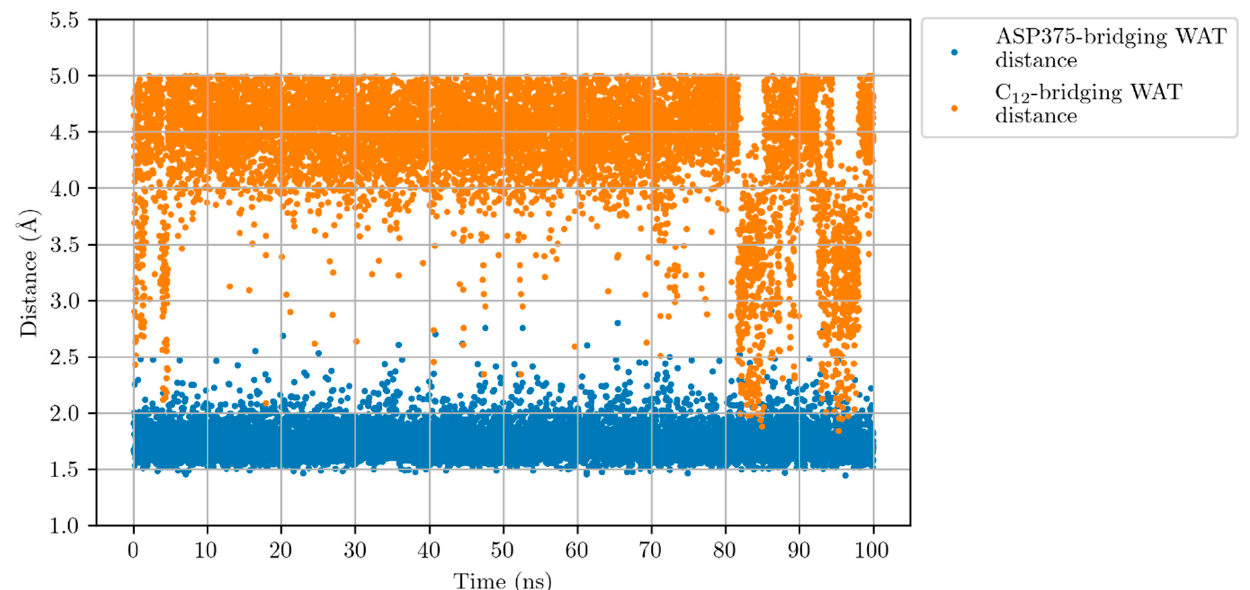
Figure 6. Distances ASP375-WAT (blue points) and C 12 -WAT (orange points) along the Molecular Dynamics simulation for the LTA 4 :LTA 4 H Michaelis complex. WAT stands for a water molecule placed between ASP375 and C 12 .